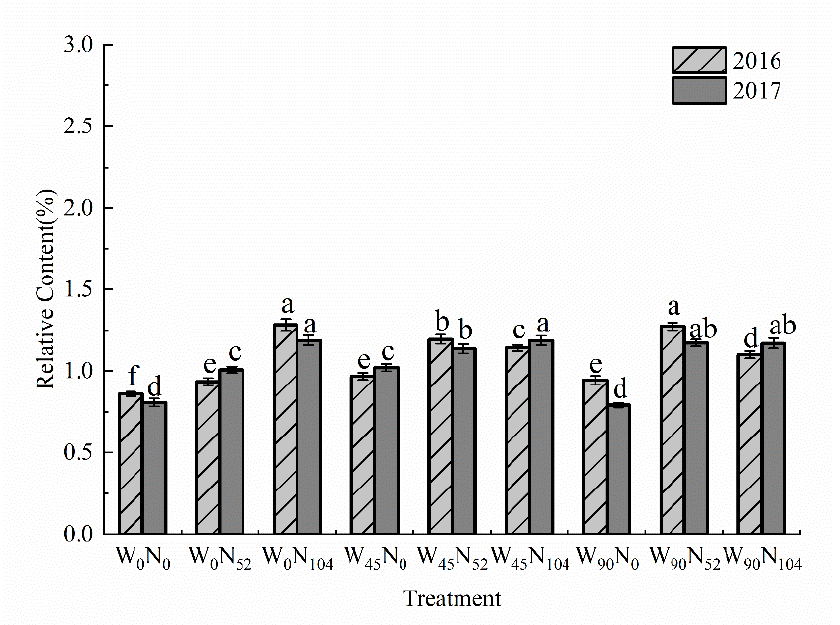
Figure 8. Effects of irrigation, nitrogen, and the interaction between the two on glycine content in sunflower seed kernels (mean ± SD; different lowercase letters indicate that there are significant differences in nine treatments at the 5% level in 2016 and 2017,respectively).